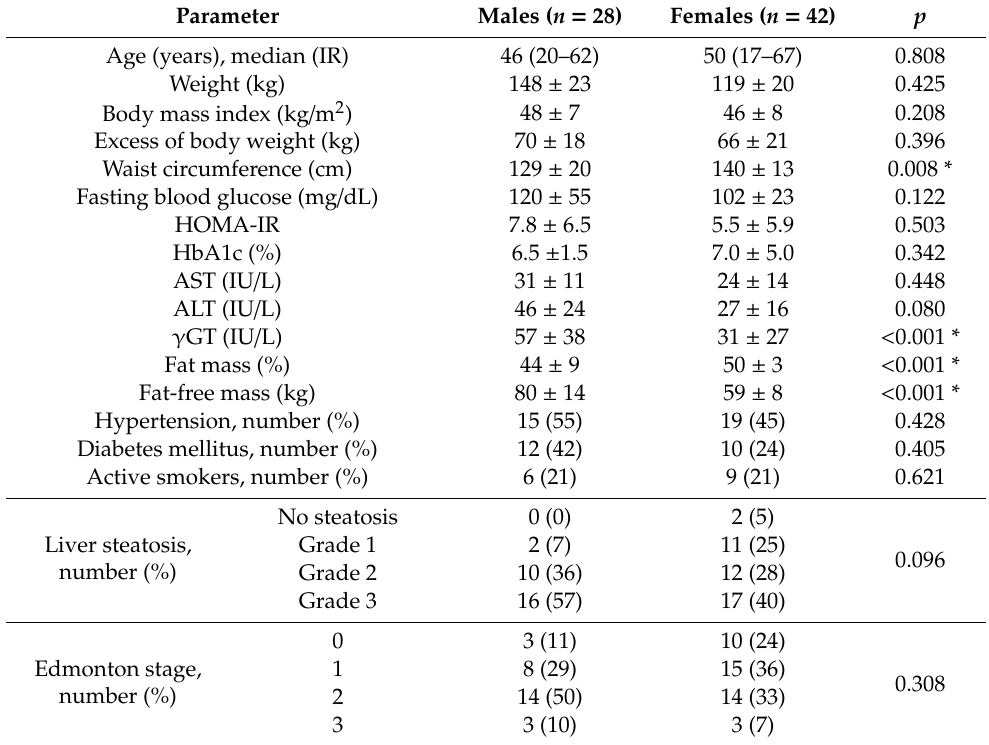
Significant di ff erences are marked with *. ALT, alanine aminotransferase; AST, aspartate aminotransferase; γ GT, gamma glutamyl transferase; HbA1c, glycated hemoglobin; HOMA-IR, homeostasis model assessment of insulin